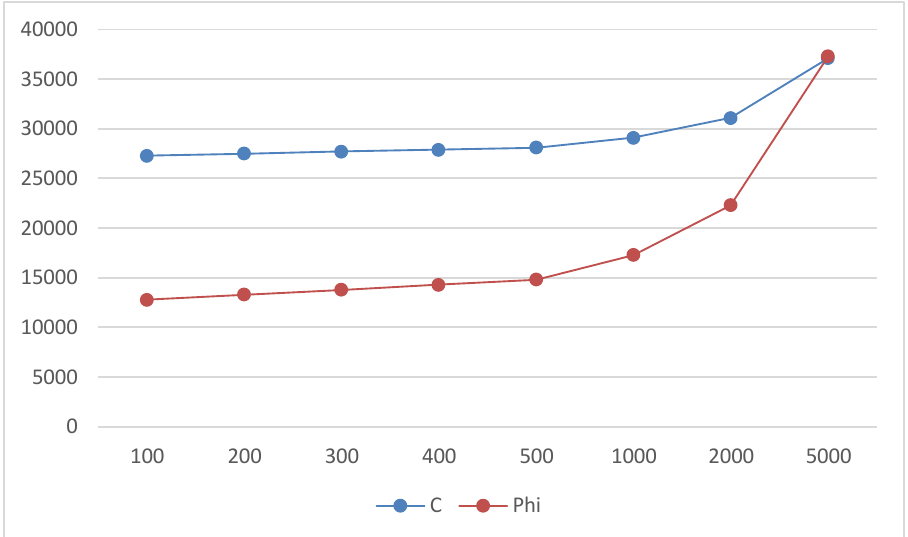
Fig. 5. Values of W under alteration of C and φ for the decentralized